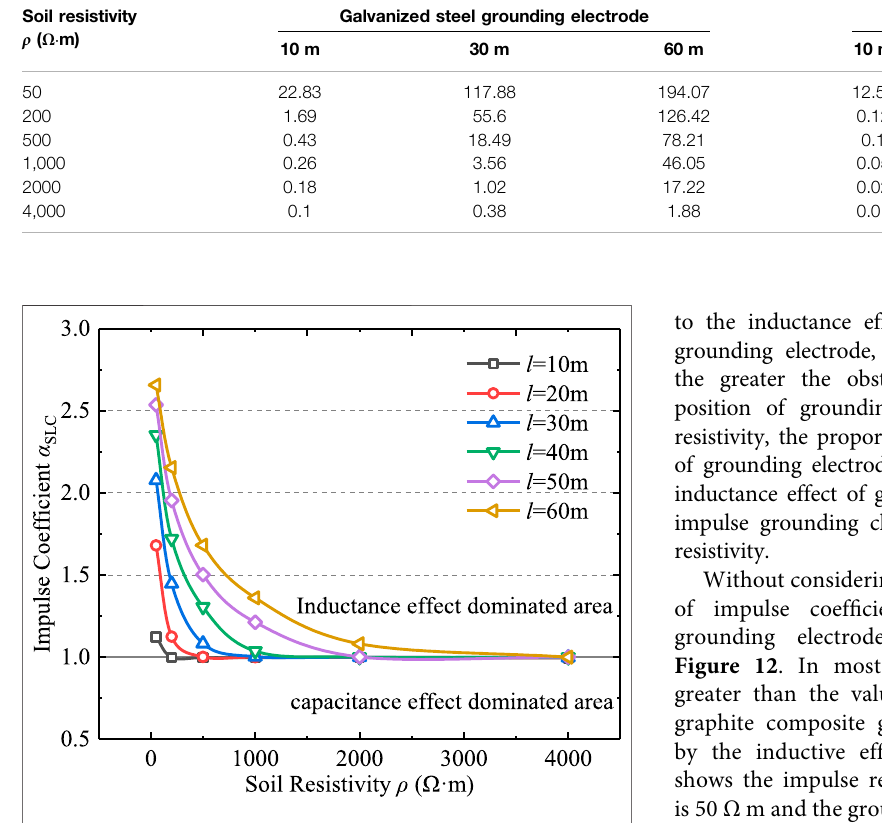
FIGURE 12 | Impulse coef fi cient of graphite composite grounding electrode without spark discharge effect.